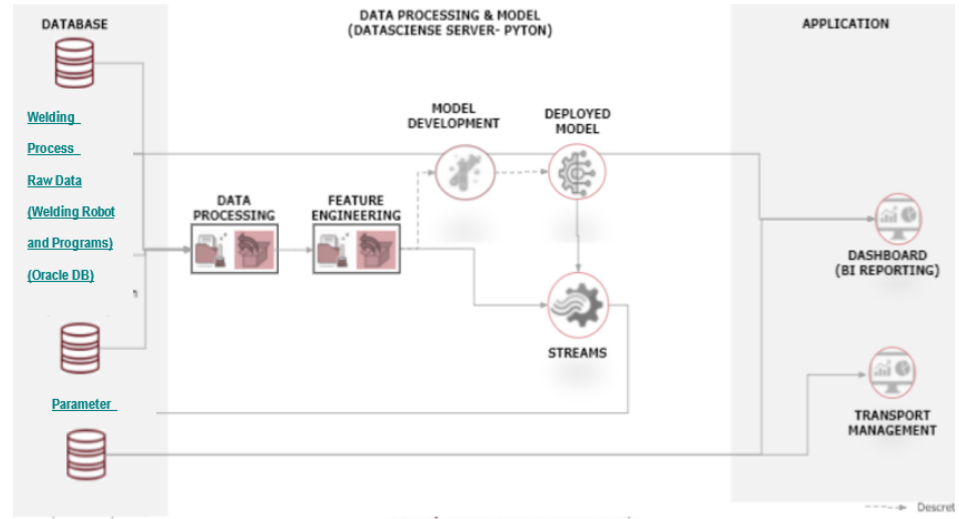
Figure 1. Methodological process and ML Model Flowchart to predict welding quality.